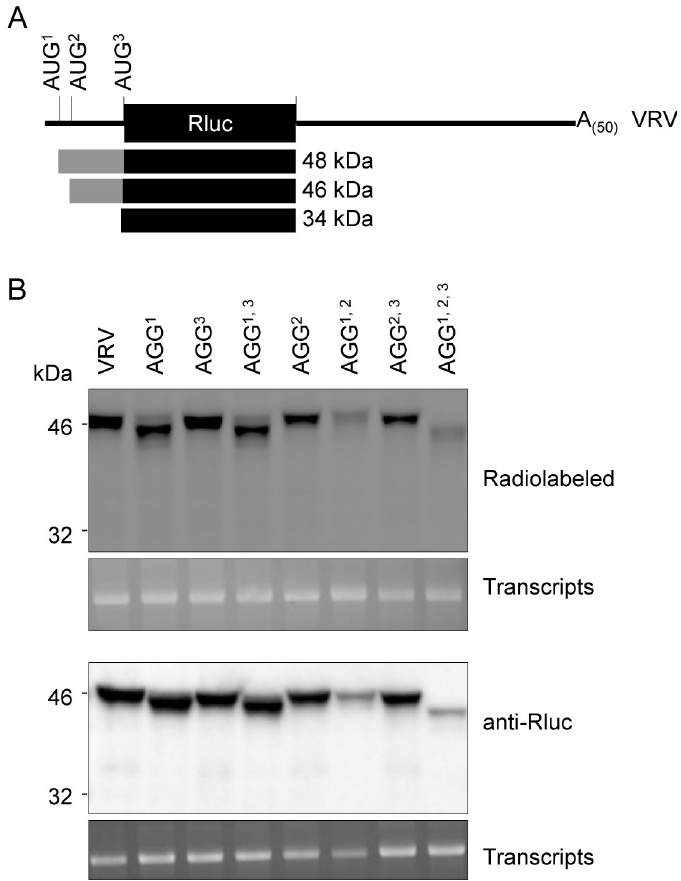
Fig 3. In vitro translation of the VRV transcript initiates at the first AUG of the viral 5’ UTR. (A) Schematic representation of the wild-type reporter transcripts (VRV) with the three putative AUG-start codons (AUG 1 , AUG 2 , AUG 3 ). Fusion Rluc proteins produced from each AUG are shown with rectangles along with their predicted molecular mass. The solid black rectangles represent the Rluc protein and the grey rectangles represent the portion of viral polyprotein sequences fused in-frame with Rluc after translation initiation at AUG 1 or AUG 2 . (B) In vitro translation of WT and AUG mutant transcripts. Detection of Rluc by radiolabelling or after probing with Rluc antibody shows the Rluc proteins produced from the wild-type VRV transcript and from the AUG to AGG mutant derivatives. Pictures of EtBr-stained RNA show the integrity of the corresponding transcripts used for the in vitro translation. Migration of molecular mass size markers is shown on the